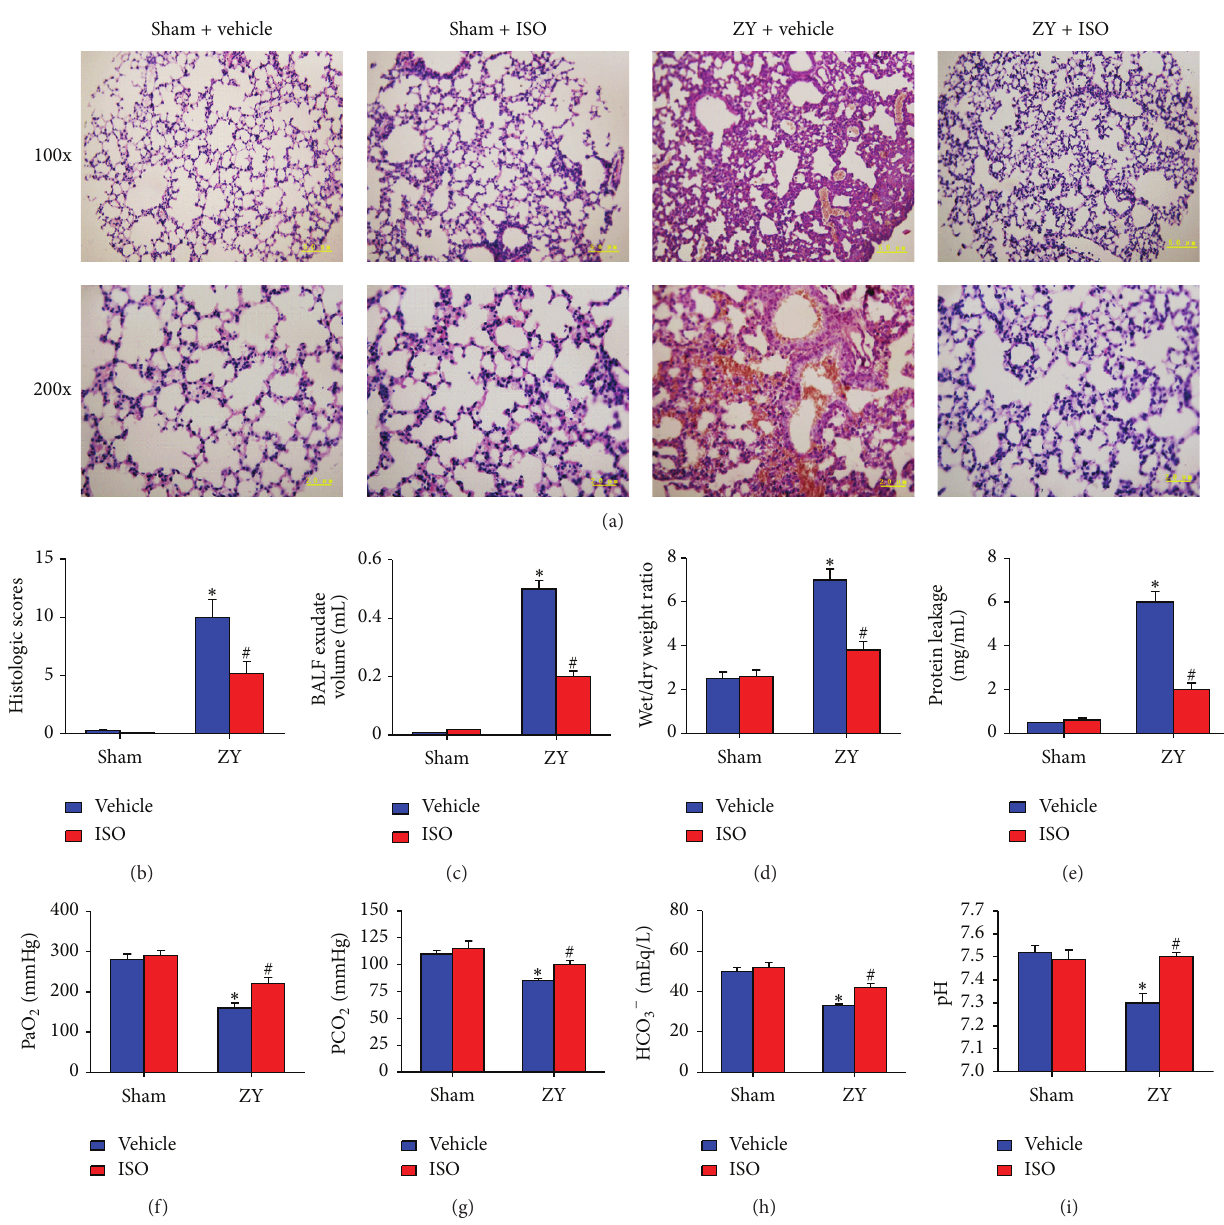
Figure 3: ISO at 0.7% preserved lung architecture and normalized lung function in ZY-challenged mice. (a) Lung morphology as assessed by hematoxylin and eosin staining (top, 100x magnification; bottom, 200x magnification). (b) Histologic scoring for the treatment groups in Figure (a). ((c)–(e)) Measurement of markers of lung injury: BALF exudate volume (c), lung wet/dry weight ratio (d), and protein leakage (e). ((f)–(i)) Measurement of markers of lung intactness: PaO 2 (f), PCO 2 (g), HCO 3− (h), and pH (i). The animals were treated as shown in Figure 1(a). Data represent means ± SD ( 𝑛 = 10 mice per group). ∗ 𝑃 < 0.05 versus sham + vehicle # 𝑃 < 0.05 versus ZY +